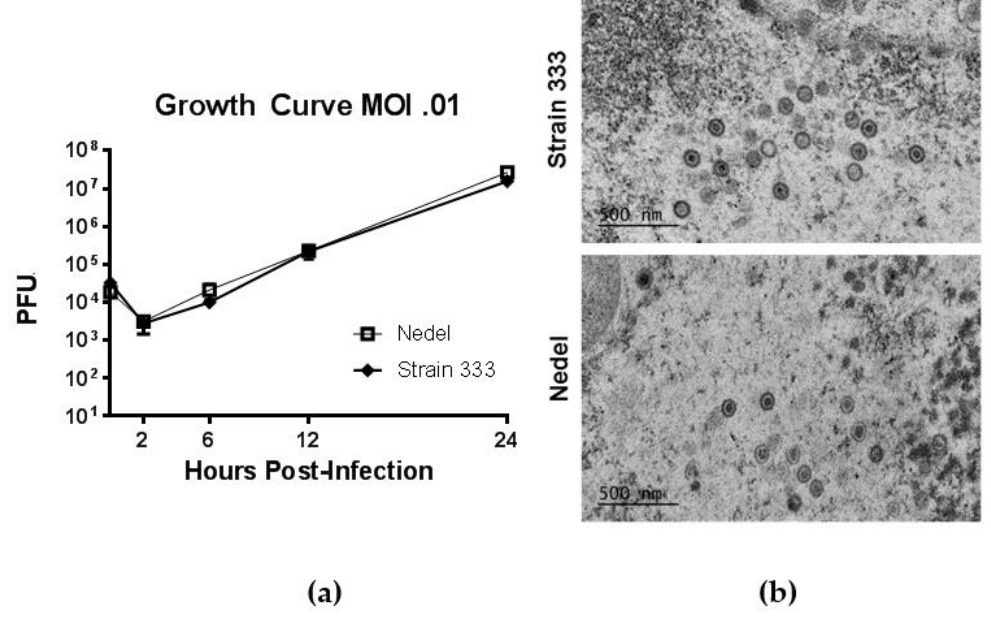
Figure 4. Replication of Nedel in vitro. ( a ) Growth Curves of Strain 333 and Nedel in Vero cells. Data points are the mean of three separate titrations and error bars reflect SEM. ( b ) Epoxy-resin-embedding transmission electron microscopic images of Strain 333 and Nedel in Vero cells.